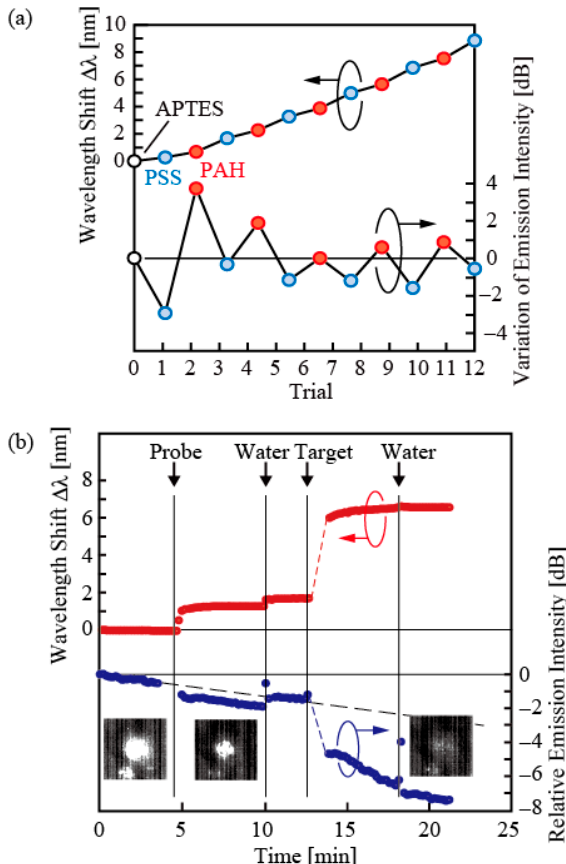
Figure 8. Change in oscillation wavelength and emission intensity by the adsorption of charged medium. ( a ) Alternate adsorption of polyelectrolytes. ( b ) Probe/target DNA adsorption.